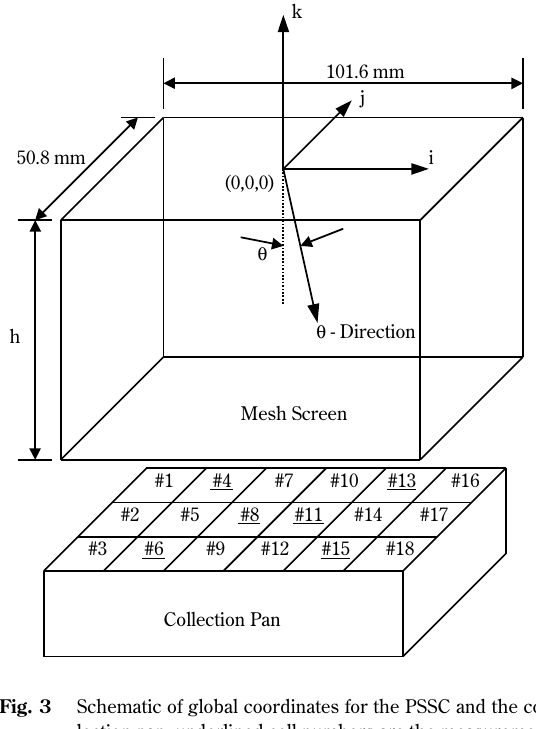
Schematic of load cell collection assembly (a) isometric view, (b)